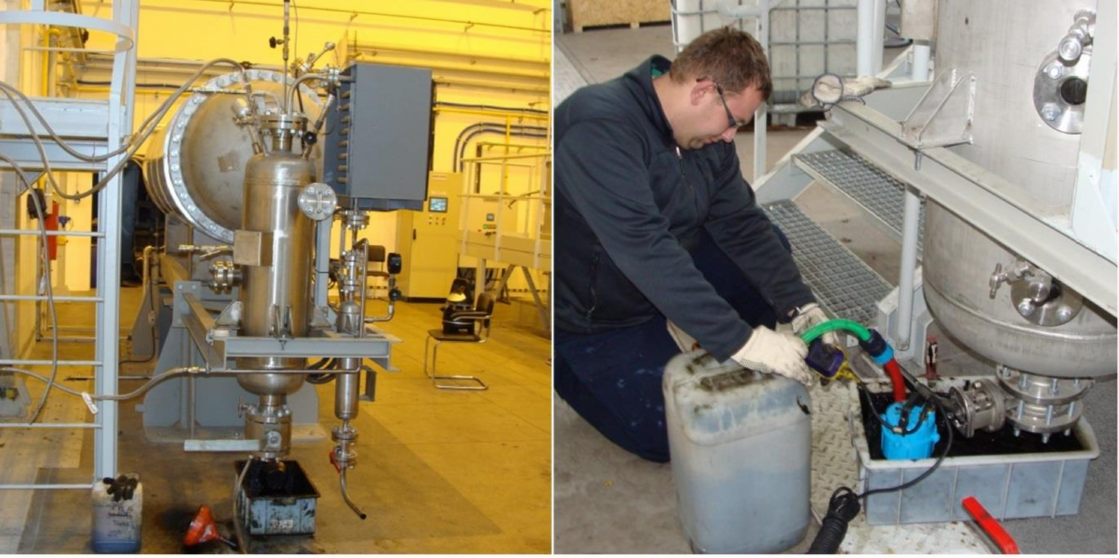
Figure 2. Water scrubber—wastewater sampling